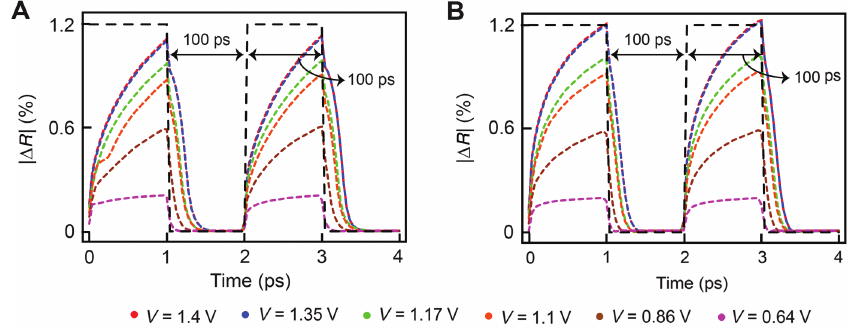
Figure 5: SPPD switching. Far-field absolute change in reflectivity (dashed lines) under step-type input voltage (dashed black line) under various forward bias